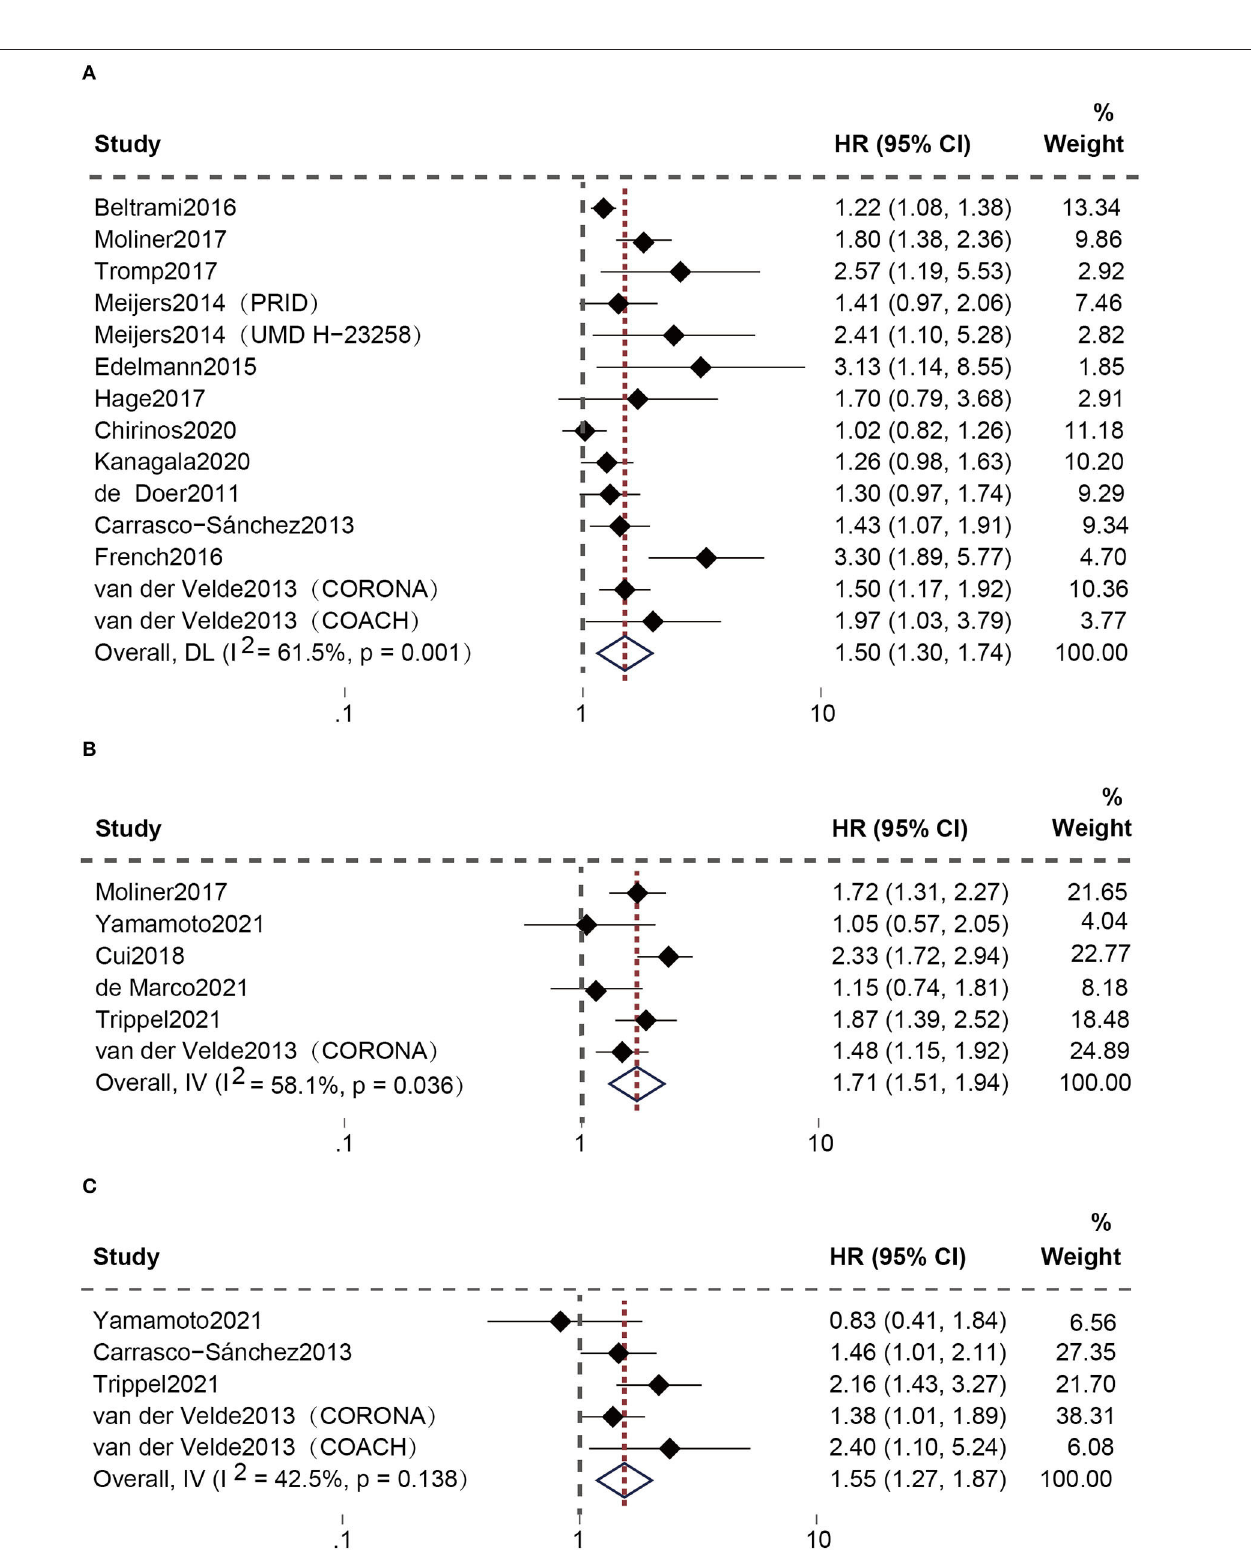
FIGURE 3 | Association between elevated plasma Gal-3 levels and adverse outcomes of HFpEF patients: (A) Association between plasma Gal-3 and the composite endpoint of all-cause death and HF hospitalization. (B) Association between plasma Gal-3 and the composite endpoint of CV death and HF hospitalization. (C) Association between plasma Gal-3 and all-cause